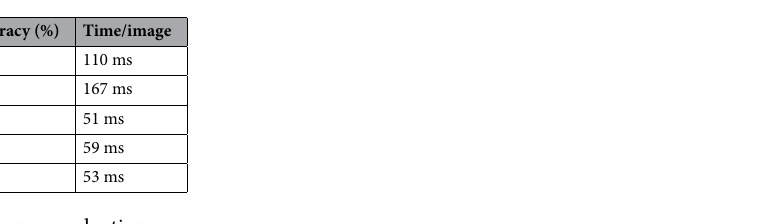
Table 3. Result of the accuracy